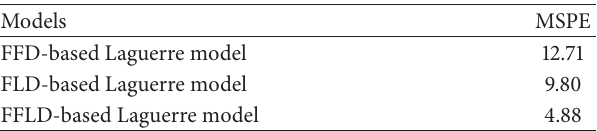
Table 2: Mean square prediction errors for the analyzed models;